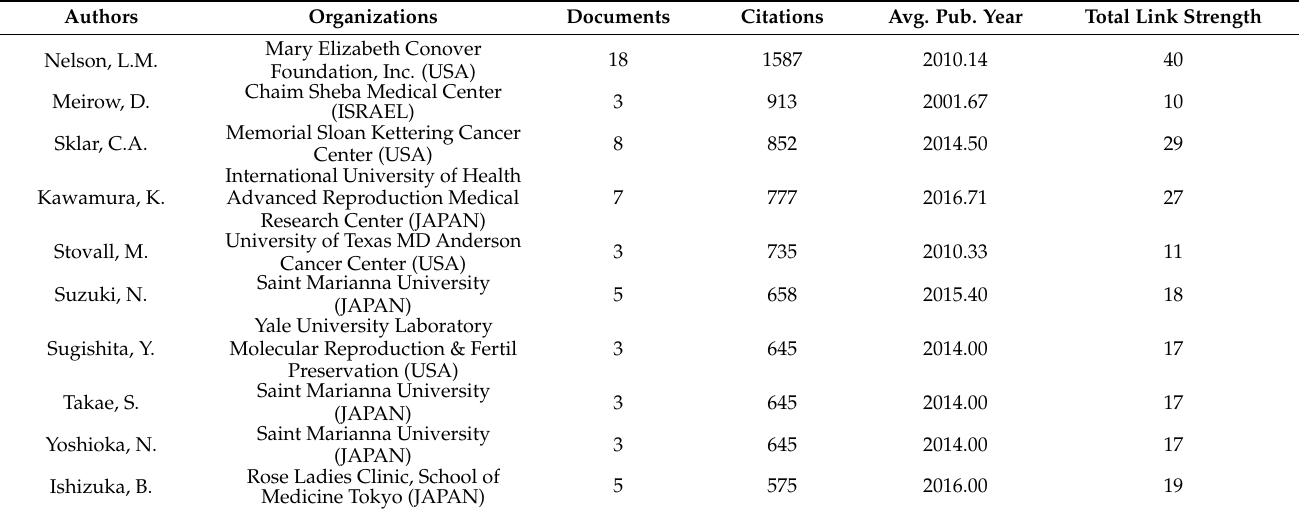
Table 4. Top 10 core authors of publications on therapy for POI from 2000 to 2022.